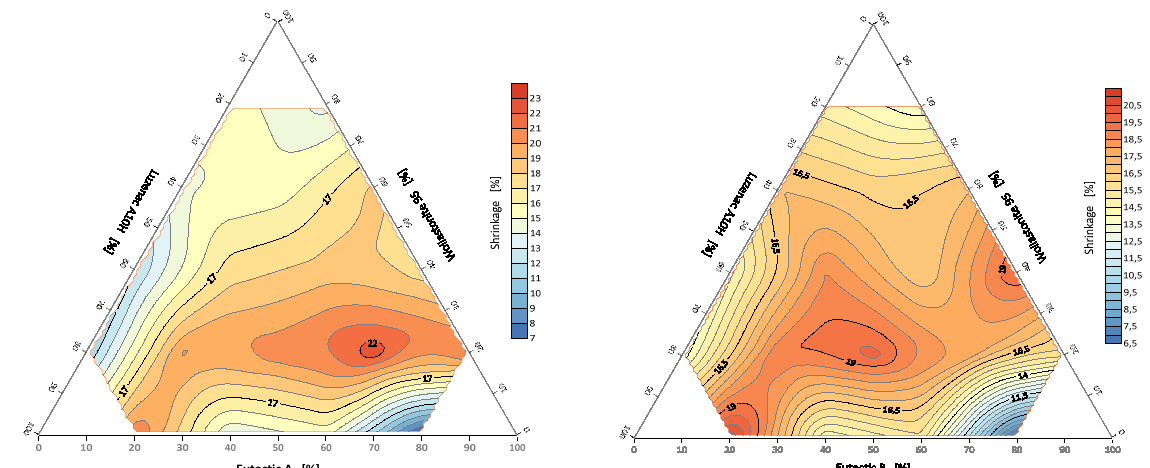
Figure 8. Shrinkage at corner rounding temperature of system: A/B-eutectic–Luzenac A10H–Wollastonite 95. Shrinkage tests were repeated on samples formed by pressing. The lozenges of the triangular composition A-eutectic–talc–wollastonite were fired at 1145 ◦ C, and the triangular composition of B-eutectic–talc–wollastonite at 1218 ◦ C. These temperatures are the lowest determined hemisphere temperatures (Figure 3). The highest linear shrinkage was observed for the composition containing a 100% A-eutectic set and was 13.5%, and for the set containing 100% B-eutectic this value was 9.9% (Figure 9). The second highest was set 9 for A-eutectic (60% A-eutectic and 40% wollastonite) in which the shrinkage was 11.3% and sets 9 and 13 with a shrinkage of 7.5%, and in sets 15 and 16, swelling of the samples was observed.